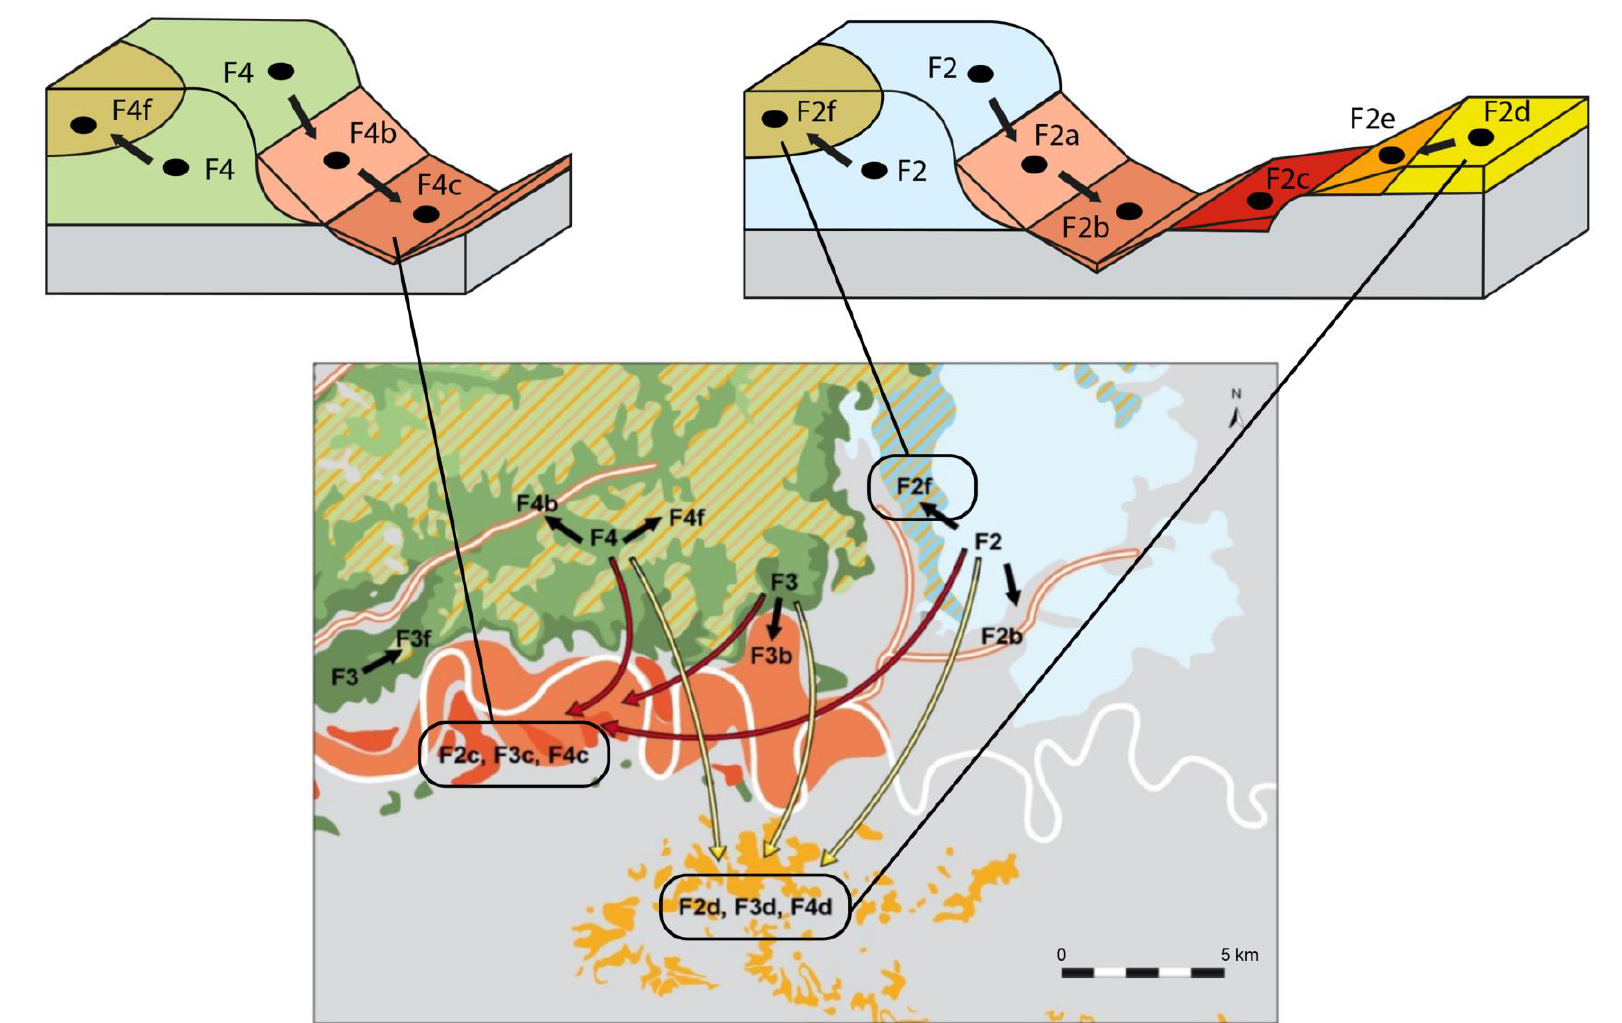
Figure 3. Theoretical view of the natural journey of a SRO. On top: block diagram; at the bottom: planimetric projection, different genetic types of SRO can found in the same secondary outcrops. Colors correspond to those of the international stratigraphic code: blue for Jurassic formations, green for Cretaceous formations, brown for alteritic formations and red, orange or yellow for Cenozoïc